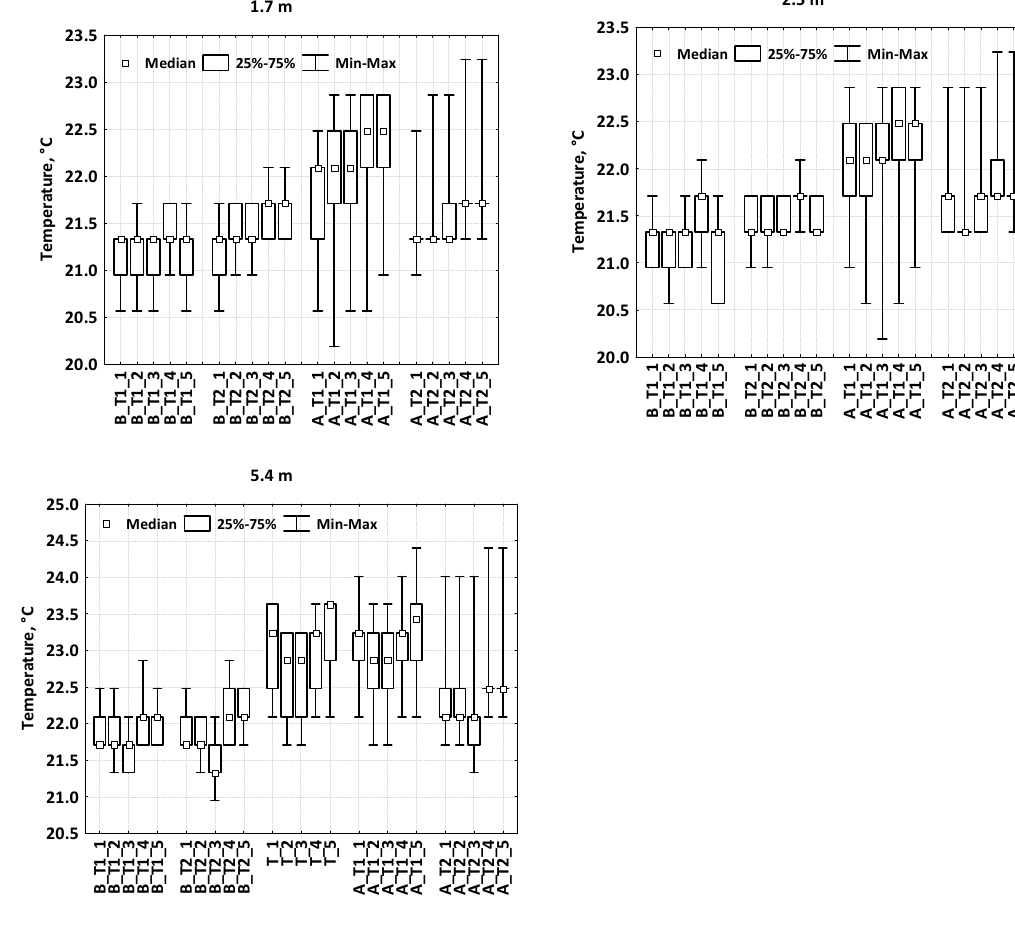
Figure 5. Indoor temperature measured at different conditions for the same height.